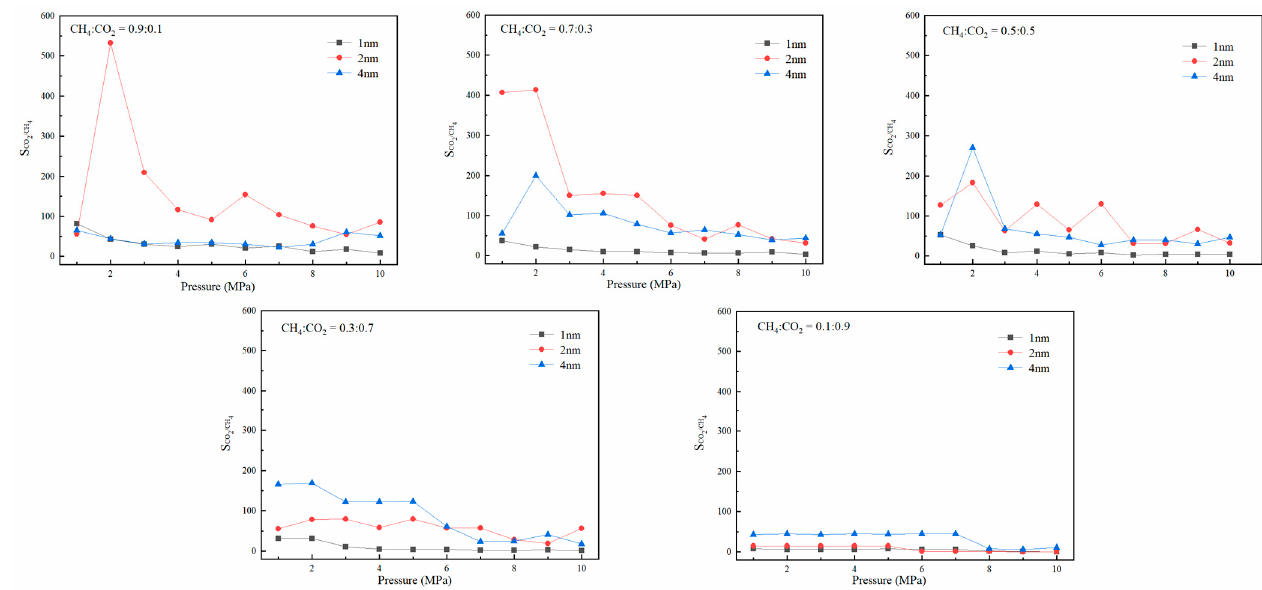
Figure 7. Adsorption selectivity of different ratios of CH 4 /CO 2 at 293.15 K.